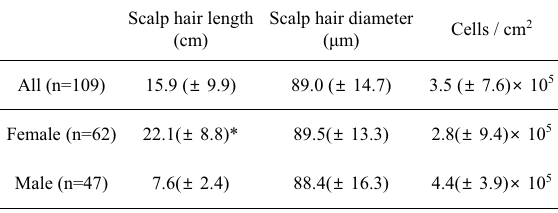
mc/slleclairetcabytisrevid-ahplA 2 on scalp hair Intrinsic Factor type factor Observed